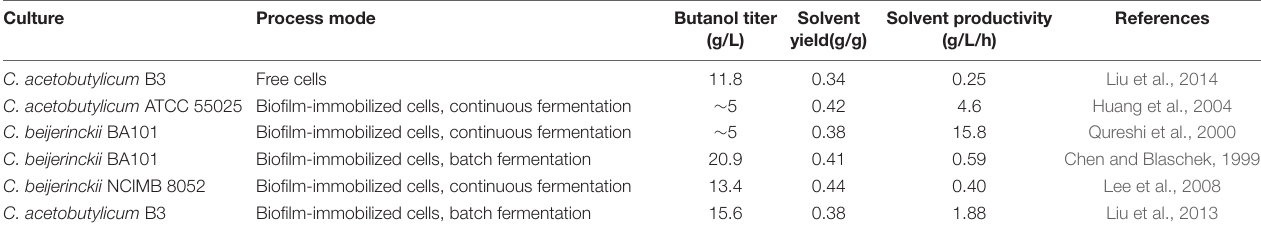
TABLE 2 | Comparison of representative fermentation results obtained from C. acetobutylicum biofilm or planktonic